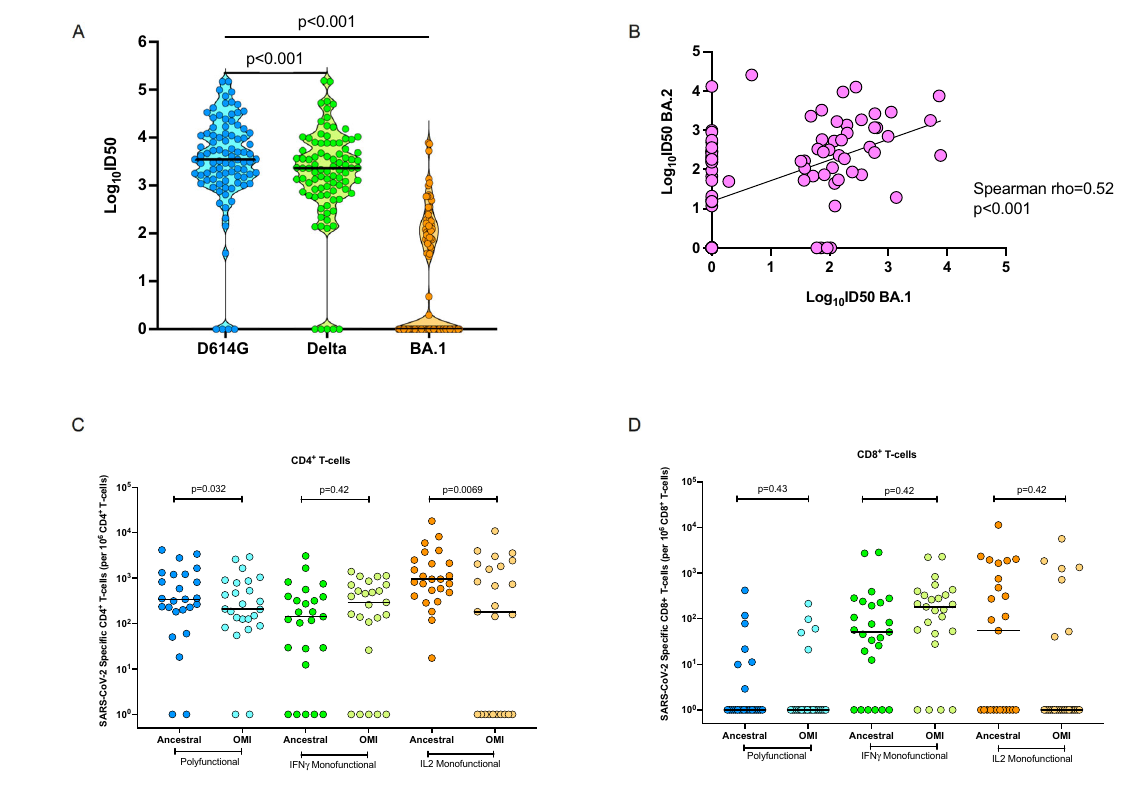
Fig. 2 | Immune response against ancestral SARS-CoV-2, Delta, and Omicron Cohort1( n =91).Atwo-tailedSpearmancorrelationwasperformed p <0.001).The BA.1 in transplant recipients with non-Omicron SARS-CoV-2 infection (Cohort diagonal line represents the best- fi t linear regression line. C Proportions of poly- 1). A Violin dot plots of the 50% neutralization titers (log 10 ID50) of neutralizing functional (IFN- γ + and IL-2 + ), IFN- γ monofunctional and IL-2 monofunctional CD4 + and D CD8 + T cells in transplant recipients recovered from non-Omicron variant antibodies against D614G, Delta, and Omicron-BA.1 variants, in transplant reci- infection (subset of Cohort 1, n =25). Horizontal lines denote the median for each pients infected with non-Omicron variant (primarily ancestral SARS-CoV-2). Each group. A two-sided Wilcoxon matched-pairs signed-rank test with Holm – Š ídák circle represents an individual patient neutralization titer. Horizontal lines repre- correction for multiple comparisons was used. Adjusted P values are shown above sent median values. P values were determined using a two-sided Wilcoxon each respective comparison. SARS-CoV-2 severe acute respiratory syndrome Cor- matched-pairs signed-rank test (D614G vs. Delta p <0.001, D614G vs. BA.1 p <0.001). B Scatter plot correlation between the log onavirus-2, OMI omicron, IFN- γ interferon gamma, IL-2 interleukin 2. Source data 10 ID50 of neutralizing anti- are provided as a Source Data fi bodytitersagainstOmicron-BA.1(x-axis)andOmicron-BA.2(y-axis)inallpatientsin